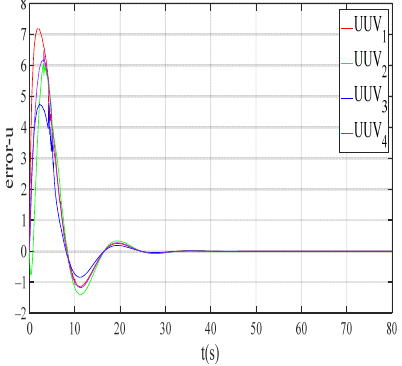
Figure 9. Velocity errors of UUVs in u and v .